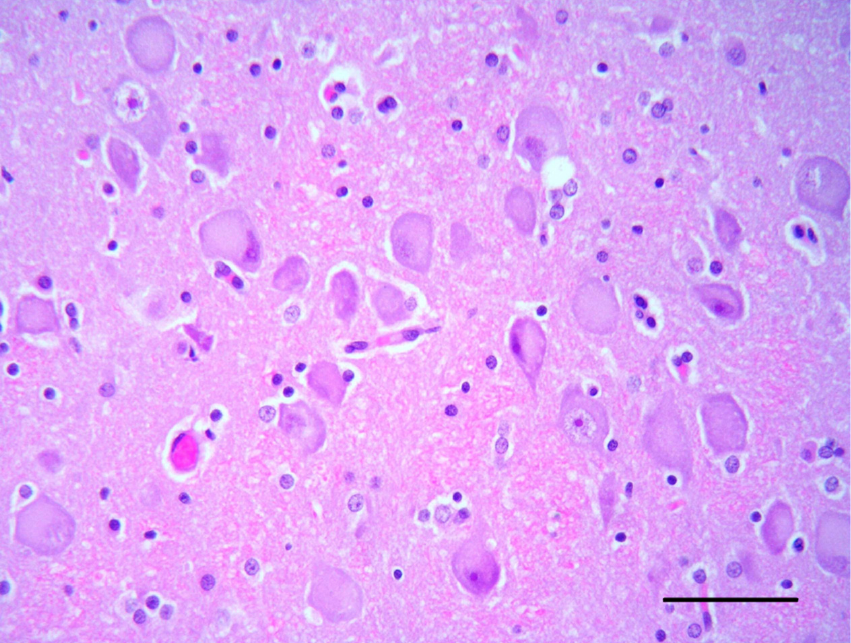
Figure 3. Cerebral cortex of dog 1. Many cortical neurons show an abnormal orientation, are enlarged with pale and eosinophilic cytoplasm and have eccentric nuclei (HE, bar = 50 μ m).